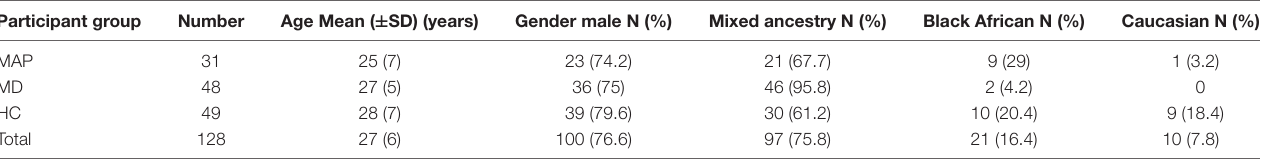
TABLE 1 | Participant demographics.